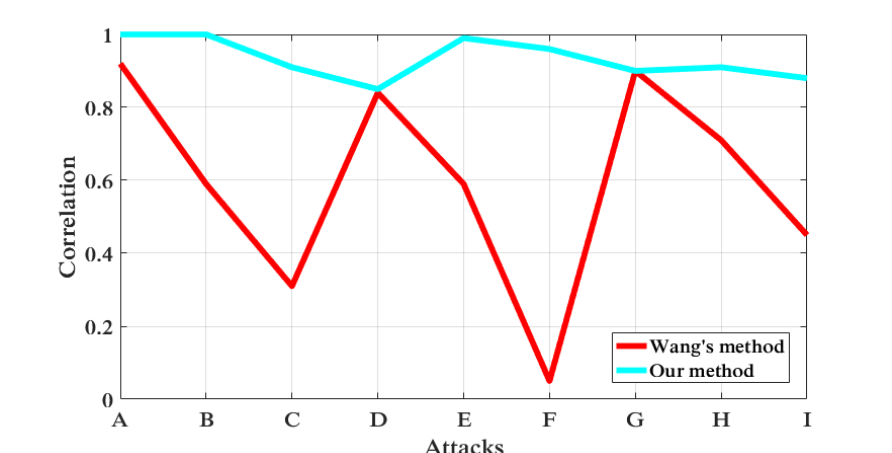
Figure 12. The robustness comparison of Cho’s method [14] with the proposed method in terms of NC for the Bunny model against several attacks: A: noise 0.1%; B: noise 0.3%; C: noise 0.5%; D: quantization of 9 bits; E: quantization of 8 bits; F: quantization of 7 bits; G: smoothing (0.3, 10 iterations); H: smoothing (0.3, 30 iterations); I: smoothing (0.3, 50 iterations).